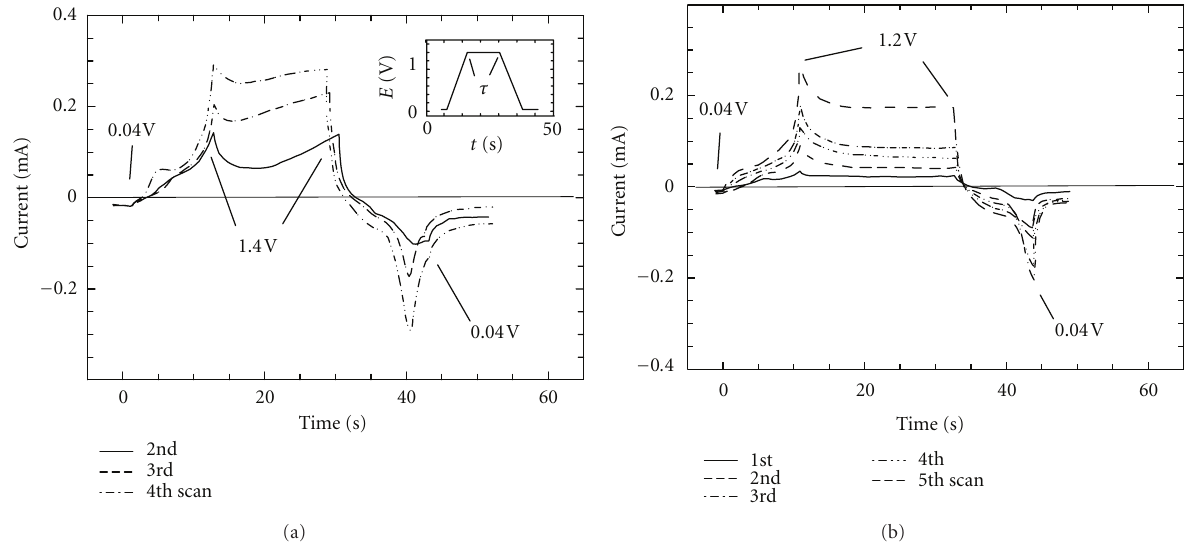
Figure 1: Potential/time programmes used in polypyrrole layer growth. Potential sweep in 0.1 M SDS, 0.1 M Py solution from Ec = 0.04 V to Ea followed by a holding time τ at Ea and consecutive cathodic scan to Ec . Scan rate 100mV/s. The di ff erent curves show the evolution of current/potential/time profiles for successive cycling using either (a) Ea = 1.4V with τ = 15s or (b) Ea = 1.2V with τ = 20